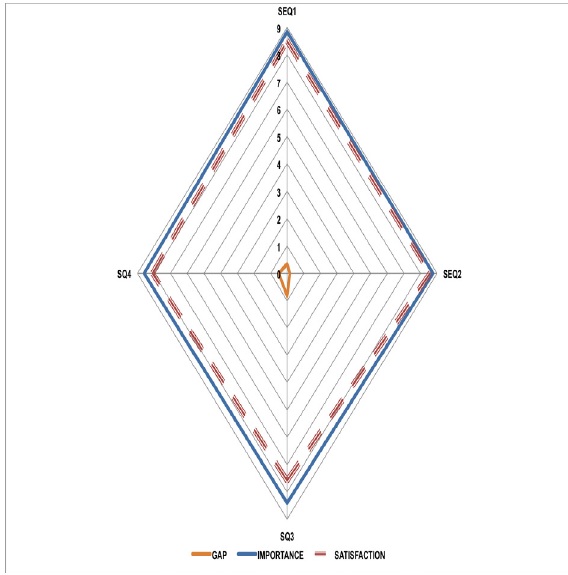
Figure 2 . Teachers’ Gap Model